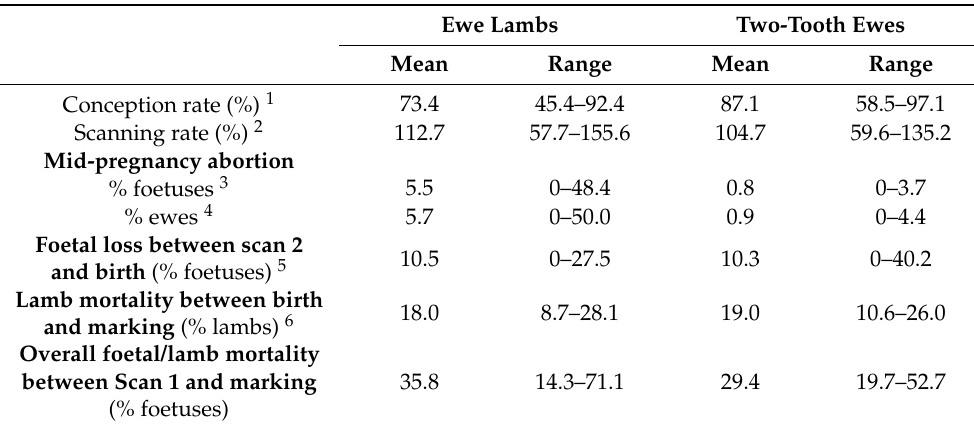
Table 3. Overall reproductive performance and timing of foetal and lamb mortalities for 19 flocks of ewe lambs and 11 flocks of maiden Merino two-tooth ewes across southern Australia between 2018 and